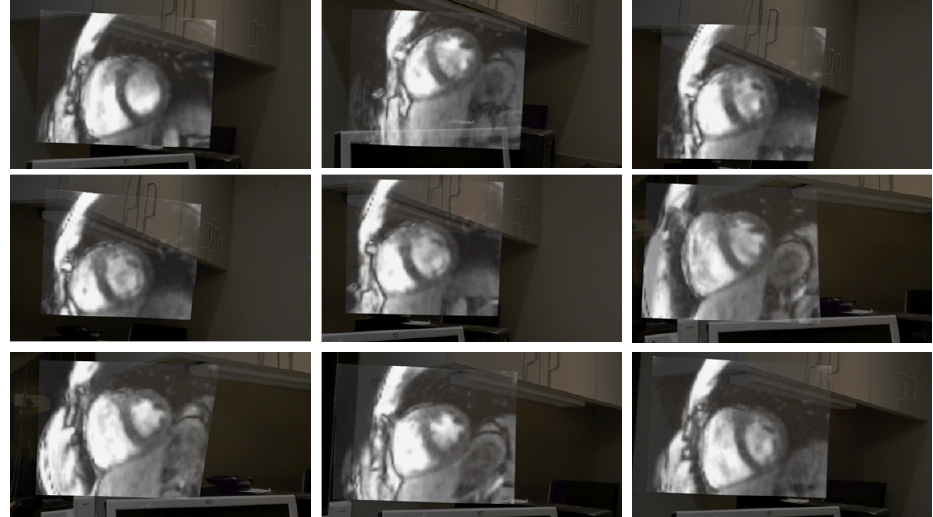
Figure 6. Multiple still frames from a user’s perspective of a volumetric scan through a mixed-reality headset are shown. The user moved around the rendering, changed the viewing angle, and moved toward and away from it. The stills were captured by a program in the headset that combines the rendering that is projected to the user with a video capture from the camera embedded in the headset. A video version of this figure is available in the Supplementary Materials.